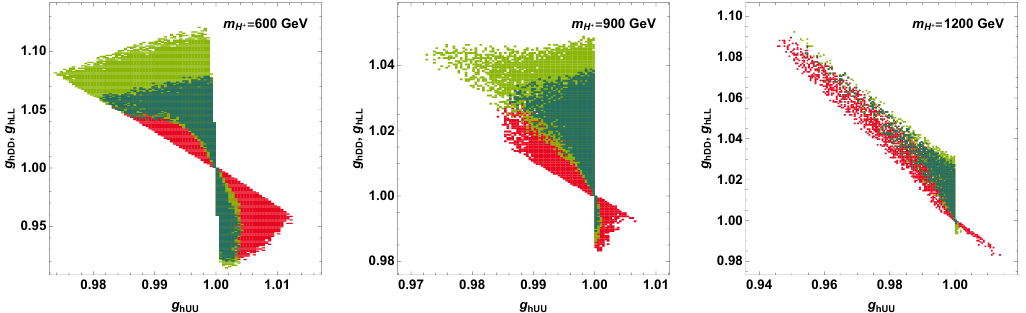
Figure 6 . The SM-normalized couplings of the 125 GeV Higgs boson. The colors are the same as in (cid:12)gure